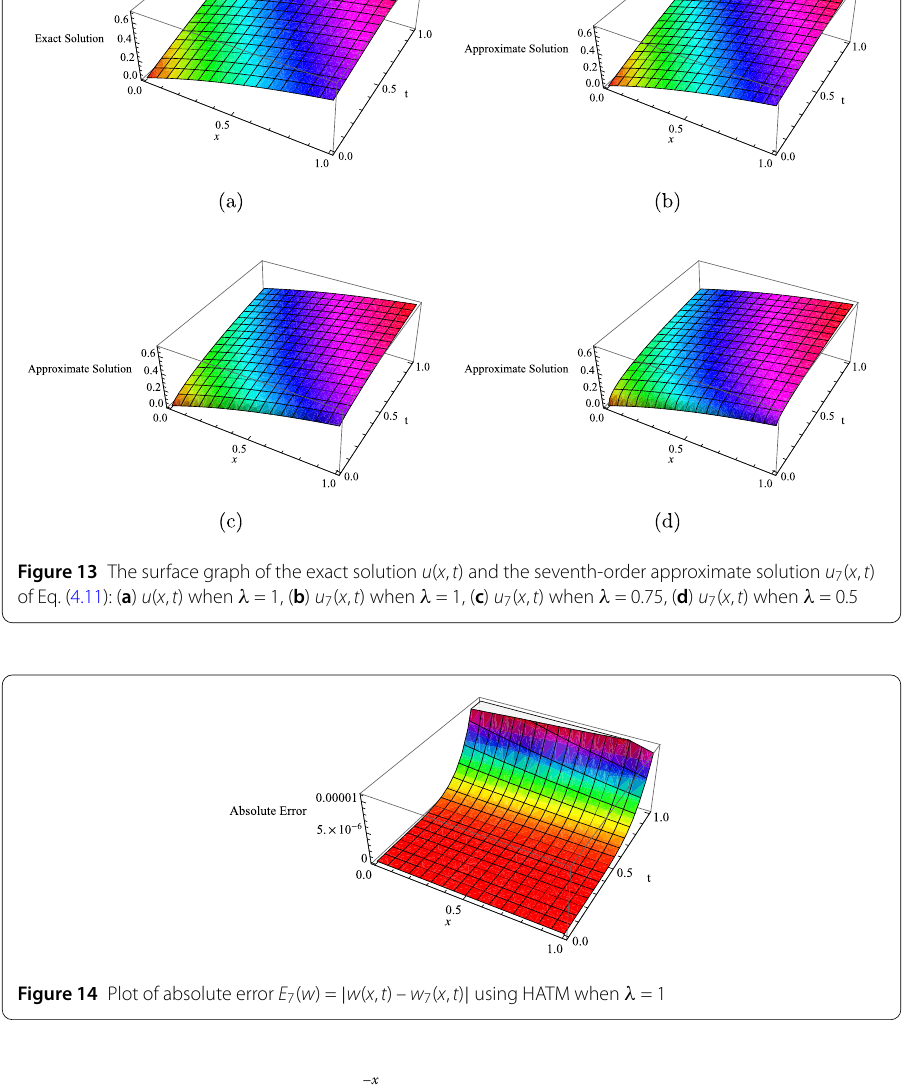
By taking w 0 ( x , t ) = w ( x ,0) = 1 – e